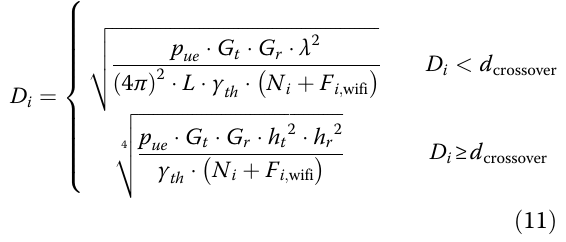
The approximate coverage of UE i is estimated by formula (11). Due to the number of actual interference sources and their location distributions, transmission powers and other information about interference estima- tion may not be available for UE i ; thus, F is an uncer- i, wifi tain value. Sometimes, it could not be guaranteed that the receiving UE i ’ s BER is below the given threshold level when the UE near the edge of cellular coverage sends data to UE i . Multiplying the result in (11) by a discount coeffi- cient η improves the probability of a lower BER of UE i that is not more than the given threshold BER, which potentially improves the throughput of UE i to avoid becoming the throughput bottleneck of the transmission path, and thus more preselected relays could be retained. The approximate coverage after discounting is as